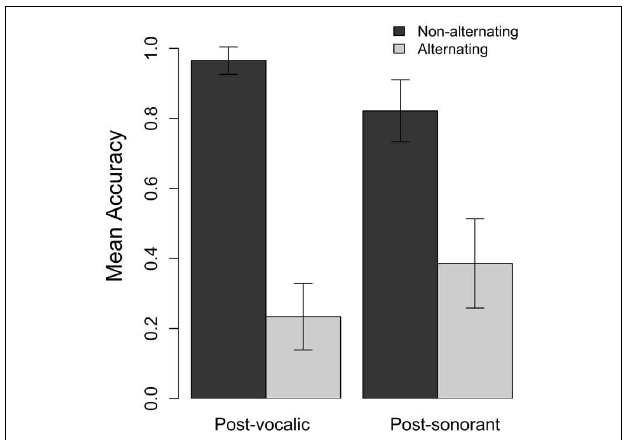
FIGURE 1 | Production accuracy in phonological context and target voicing in Experiment 1. Accurate production of voicing in non-alternating targets indicates that the child correctly produced a [t] in the plural, e.g., petten ‘caps’ as the plural of pet. Accurate production in alternating forms indicated that they produced a voiced [d] where required, e.g., in the word bedden ‘beds.’